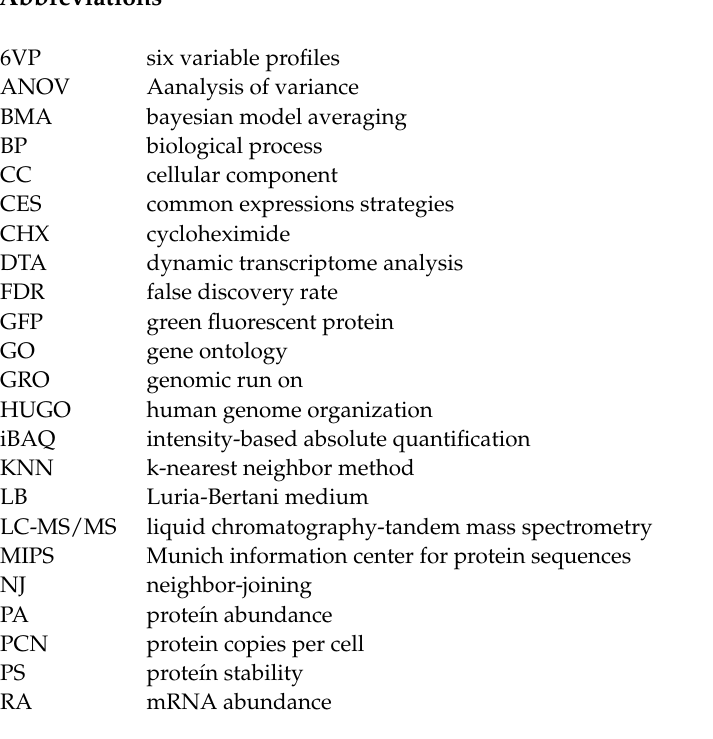
selected gene groups; Figure S3: General model for gene expression flux control; Table S1: List of the datasets used in the four organisms for the six variables; Table S2: List of the genomic data for the six variables: RA, TR, RS, PA, TLRi, PS used for Pearson’s and Spearman’s correlations in the four organisms; Table S3: List of the genomic data for the six variables in rank order, RA, TR, RS, PA, TLRi, PS, used for 6VP construction, clustering and phylogenetic trees in the four organisms; Table S4: List of macromolecular complexes and GOs not belonging to the macromolecular complexes used for the Figure 4 comparison; Table S5: List of the GO terms used for the phenogram reconstruction in Figure 5; Supplementary File S1: Whole set of clusters obtained for S. cerevisiae ; Supplementary File S2: Whole set of clusters obtained for S. pombe ; Supplementary File S3: Whole set of clusters obtained for E. coli ; Supplementary File S4: Whole set of clusters obtained for